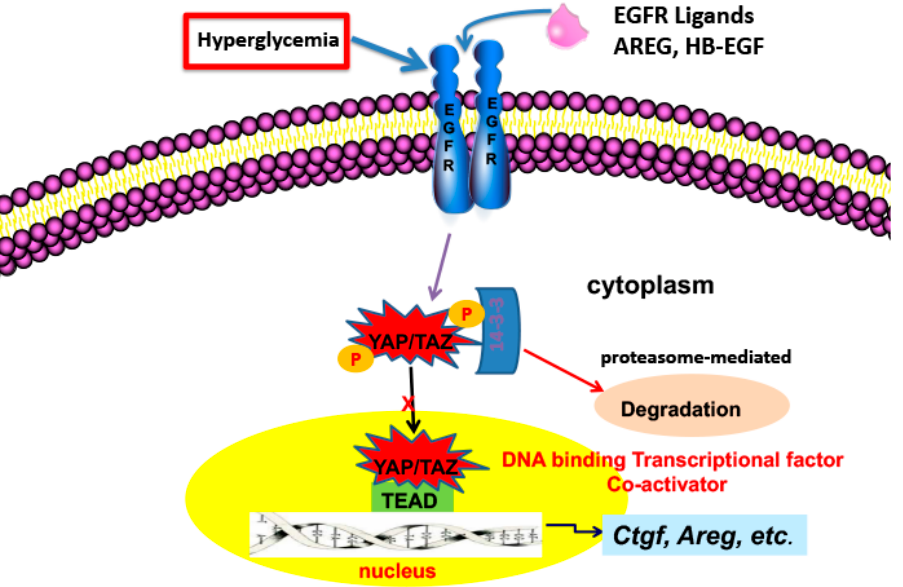
Figure 1. EGFR activation leads to increased YAP translocation to the nucleus, association with TEAD and transcription of genes involved in progressive kidney injury.